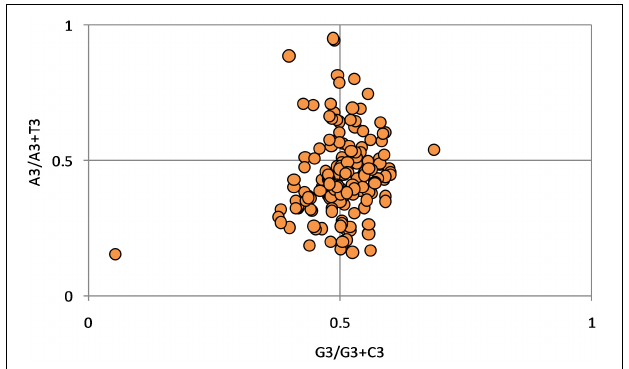
FIGURE 6 | Parity plot generated using A3/(A3 + U3) as abscissa and G3/(G3 + C3) as the ordinate. The plot exhibit the preference of T over A and G over